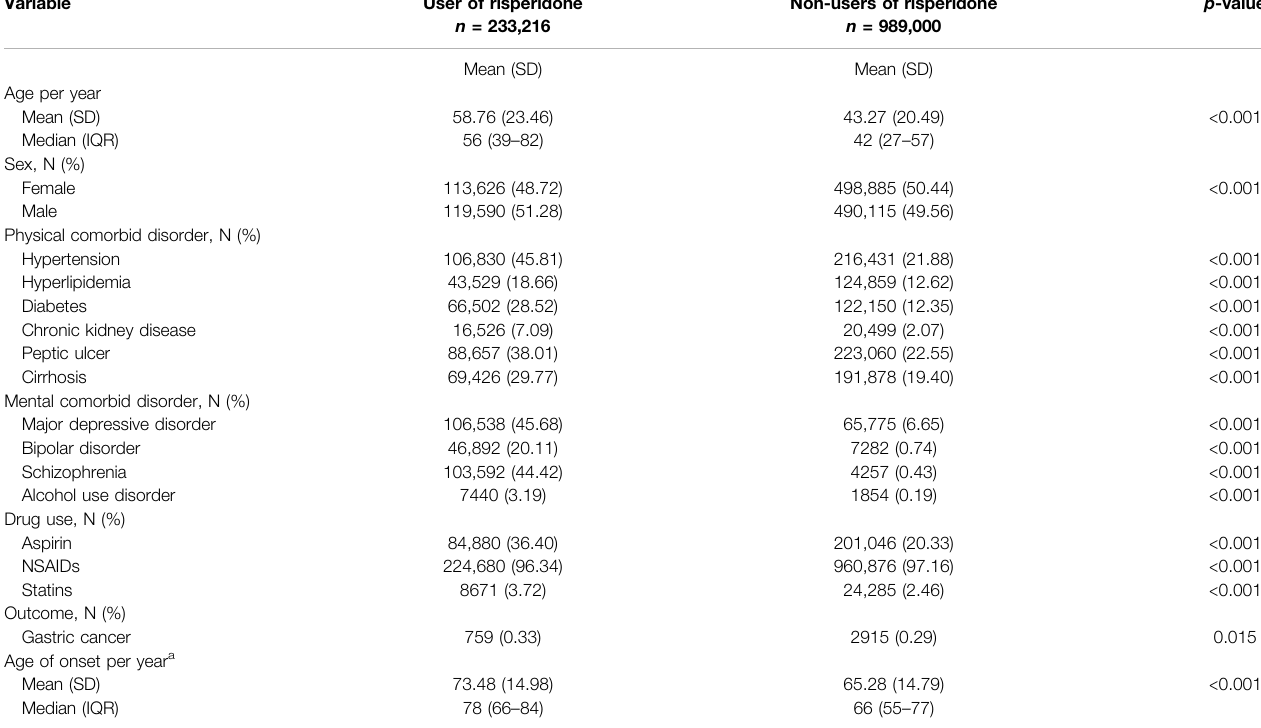
TABLE 1 | Demographic characteristics of participants in the population-based study.